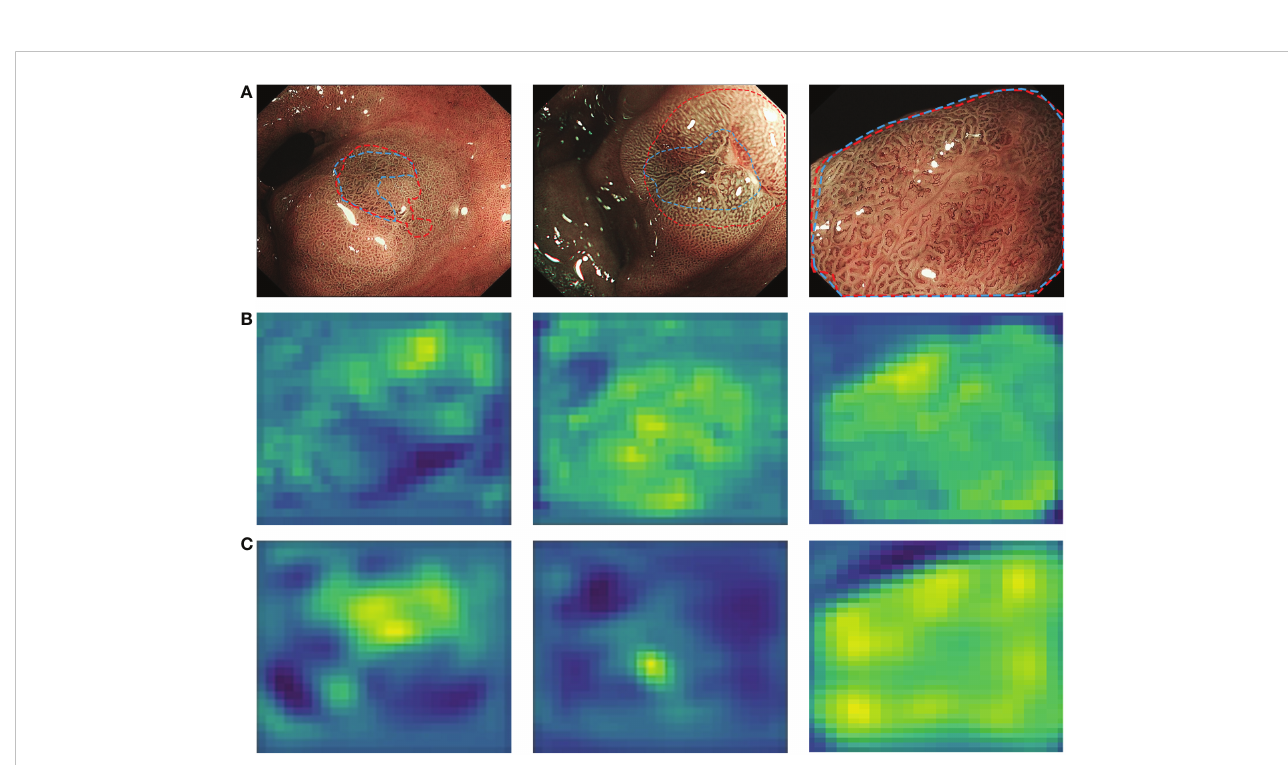
FIGURE 8 Characteristic layers extracted from endoscopist-labelled ME-NBI images by CNN2. (A) The margins of neoplastic lesions labelled by an expert endoscopist are shown as blue lines, and the margins predicted by CNN2 are shown as red lines. (B) Shallow characteristic layers of vascular and texture details extracted by CNN2. (C) Deep characteristic layers of colour details extracted by CNN2. A lighter colour indicates a high possibility of an abnormal area. ME-NBI, magnifying endoscopy with narrow-band imaging; CNN, convolutional neural